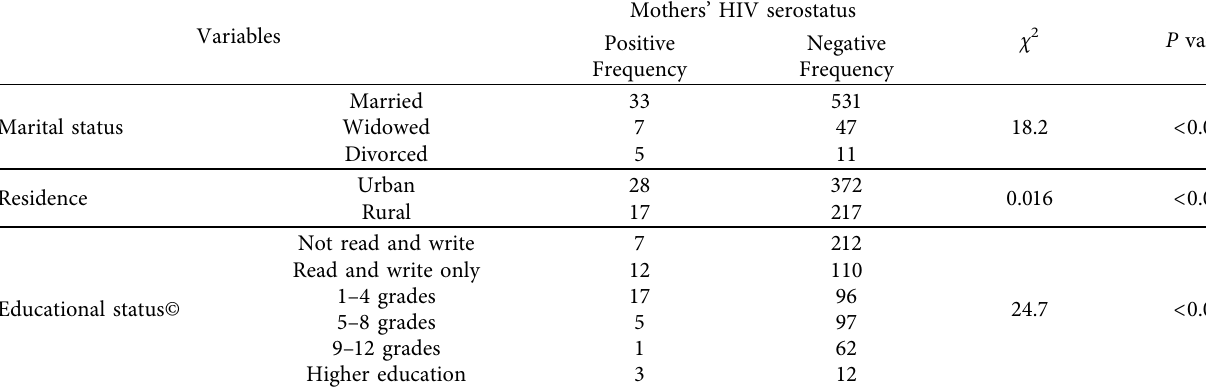
Table 3: Factors associated with maternal HIV serostatus among pregnant mothers on ANC follow-up at JUSH ( N �